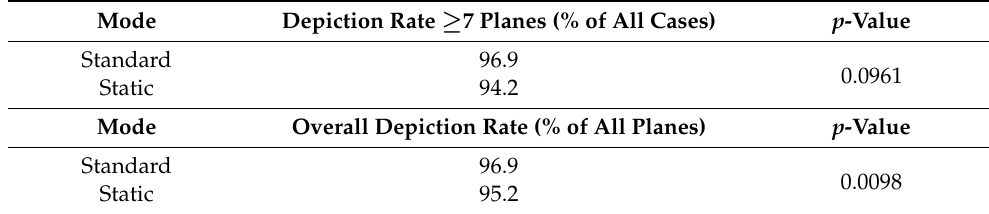
5 of 10 Table 1. Properly displayed planes for both modes.